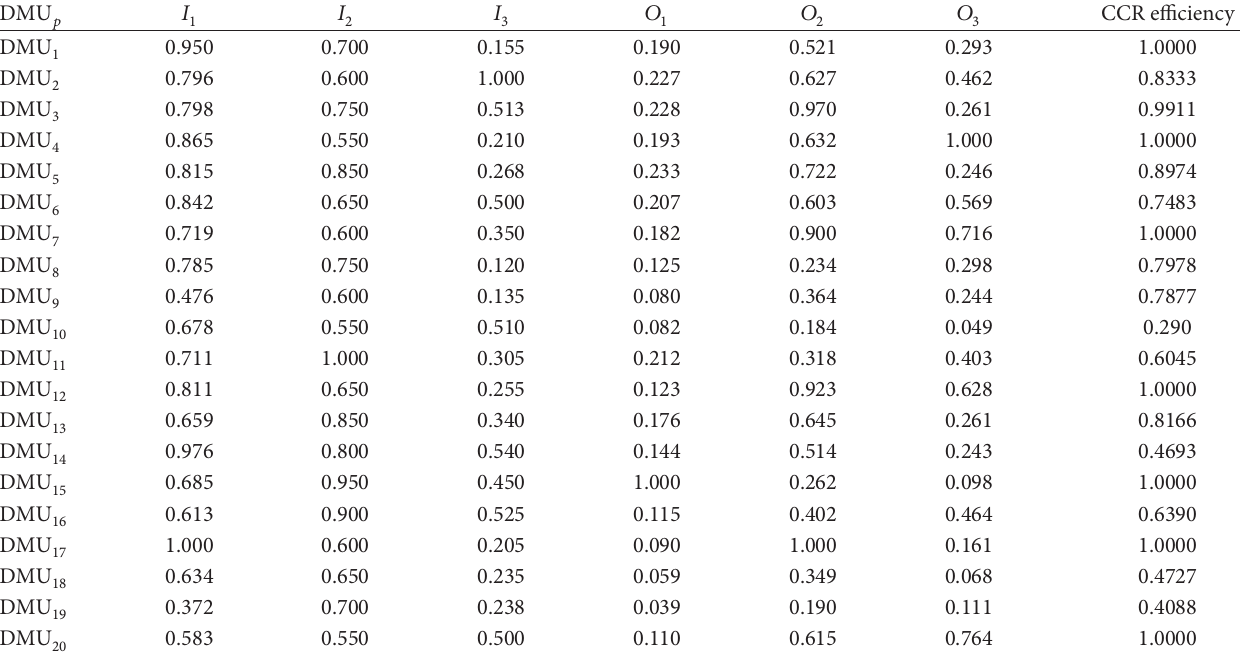
Table 1: Inputs, outputs, and efficiency scores.